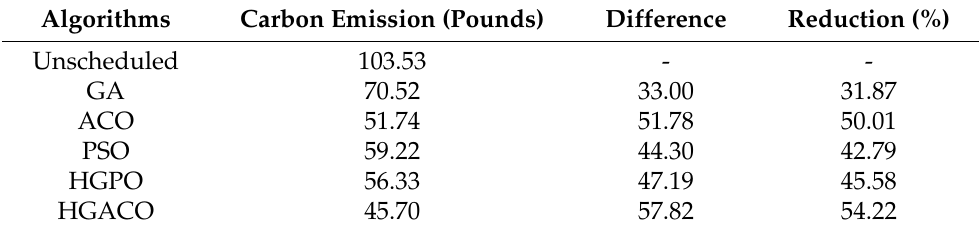
Figure 16. Carbon emission with PV. Table 11. Scenario II: carbon emission assessment with